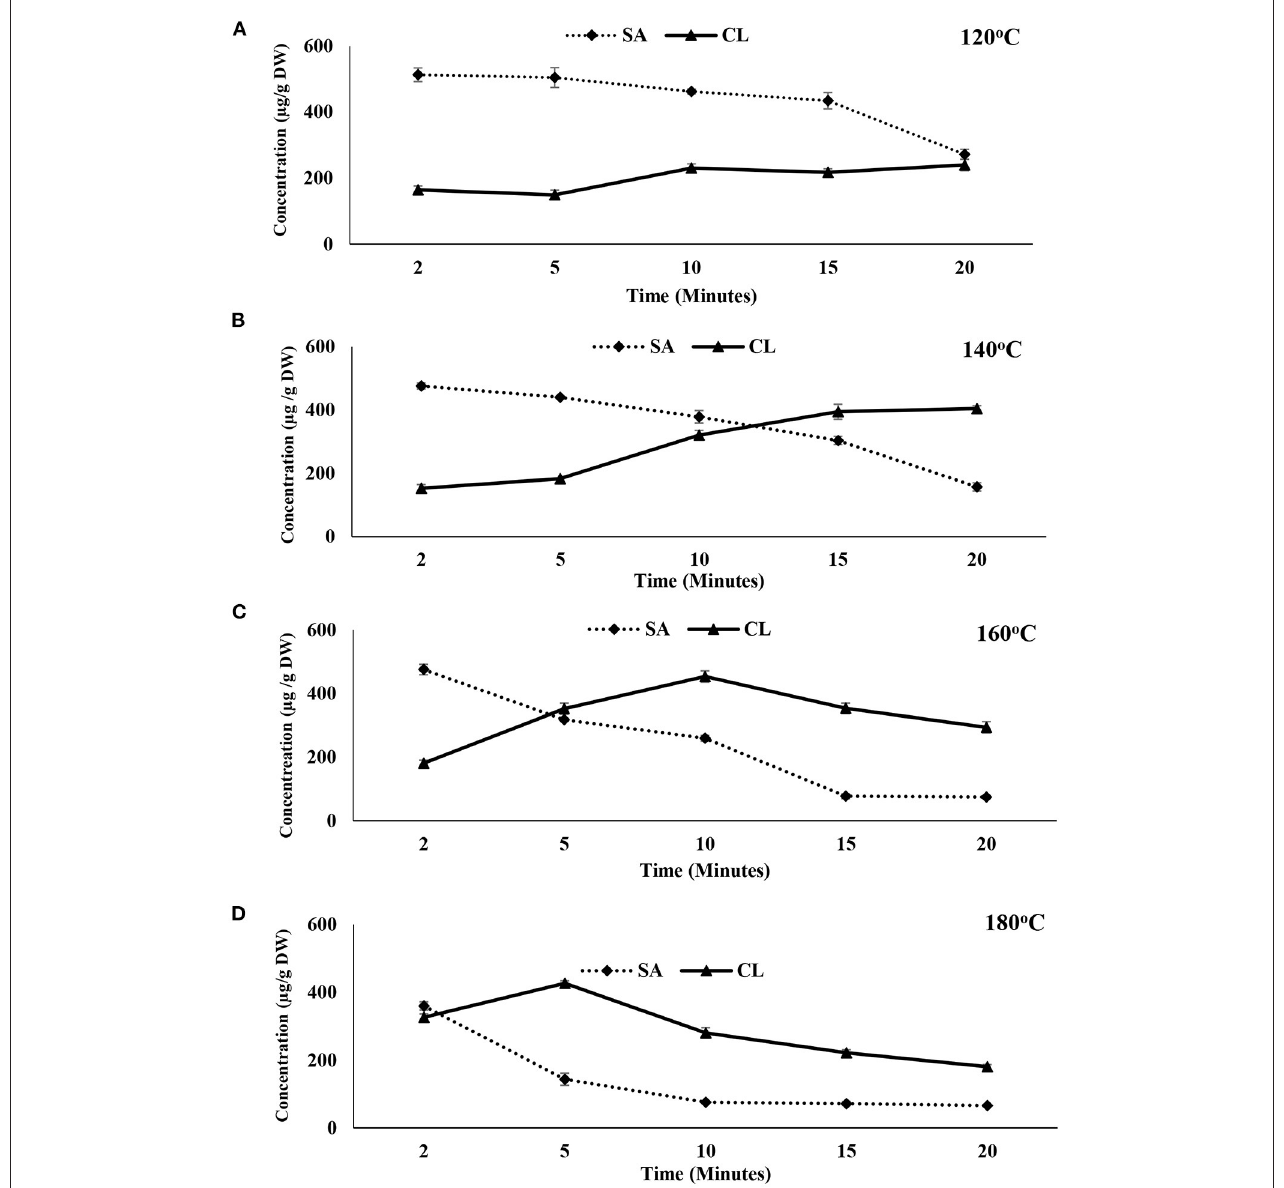
FIGURE 4 | Structure-function relationship of sinapic acid and canolol for canola meal at (A) 120, (B) 140, (C) 160, and (D) 180 ◦